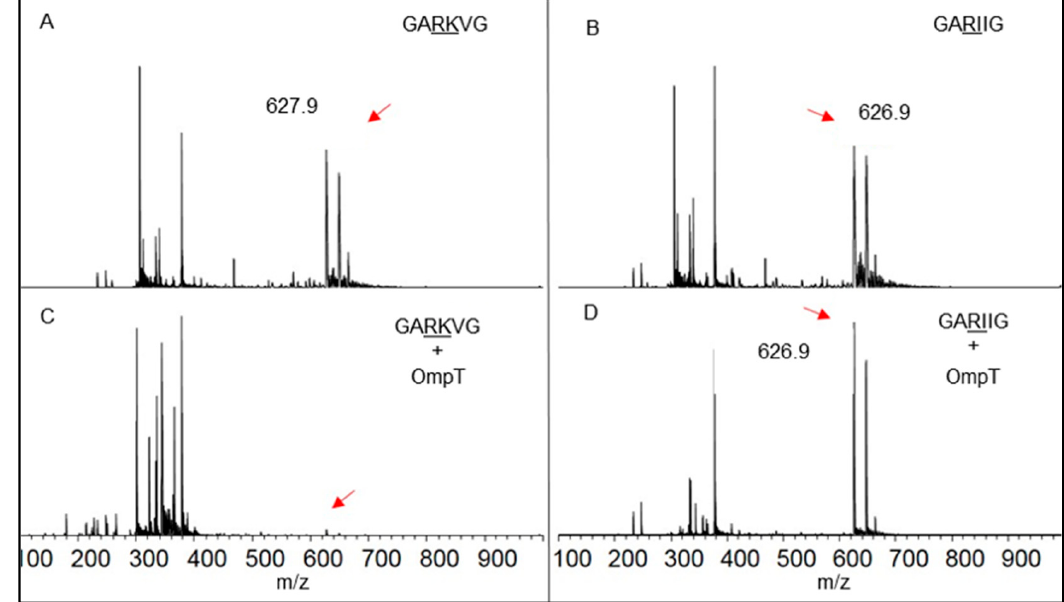
Figure 6. Characterization of substrate specificity of RC-31(LPS) for the dibasic sites: MALDI-TOF spectra of a short synthetic peptide with a dibasic site in the absence ( A ) and presence ( C ) of RC-31(LPS). MALDI-TOF spectra of a short synthetic peptide lacking a dibasic site in the absence ( B ) and presence ( D ) of RC-31(LPS). Red arrows point to the expected location of the m/z peaks for the uncleaved peptide.